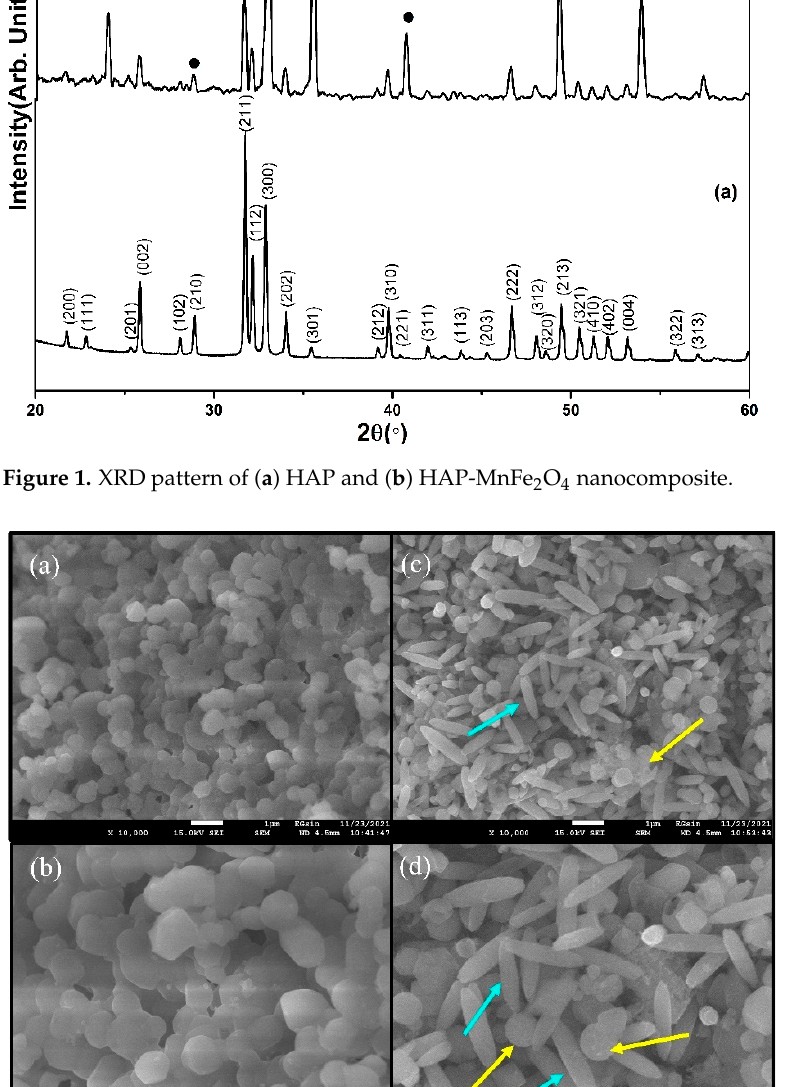
Figure 1. XRD pattern of ( a ) HAP and ( b ) HAP-MnFe 2 O 4 nanocomposite.